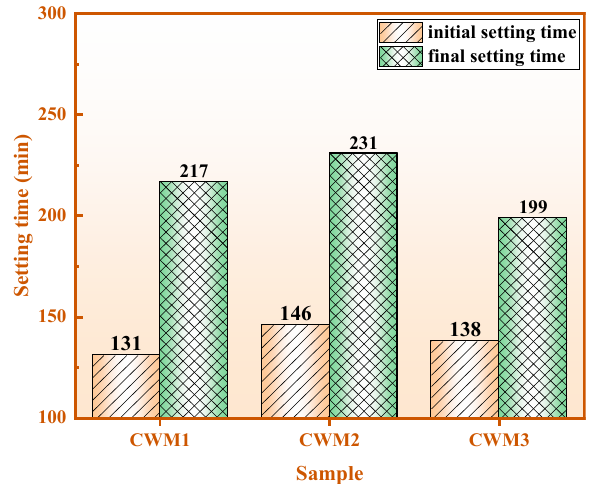
Figure 7. Setting time of three CWMs. Table 3. Index parameter of CWM (water/cement ratio of